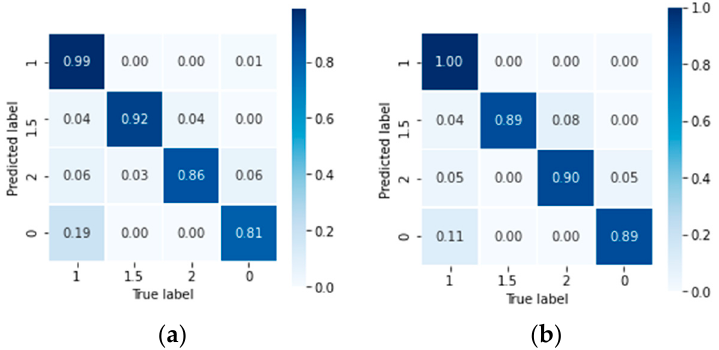
Figure 12. The normalized confusion matrix of test datasets from ( a ) M1; ( b ) M2.